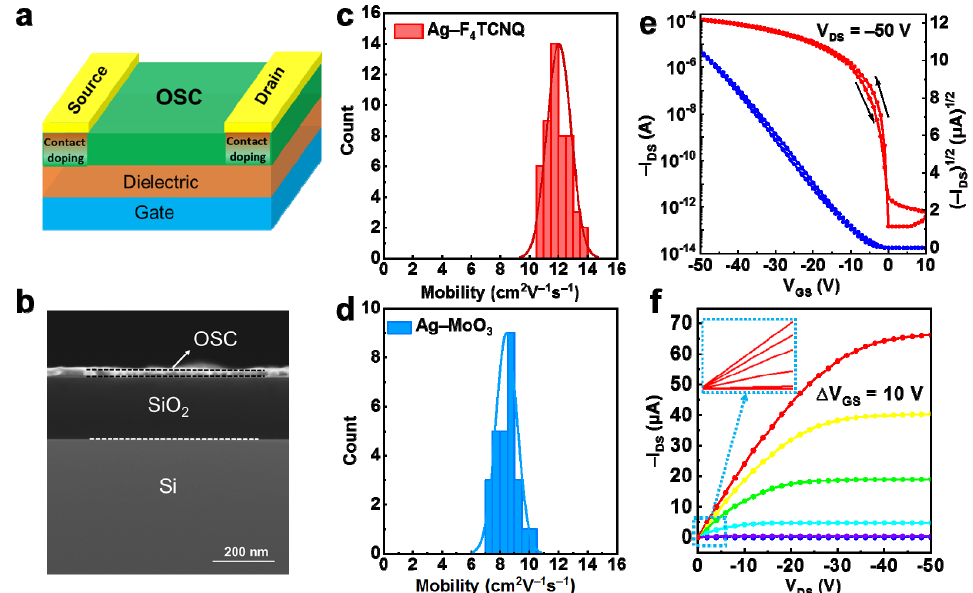
Figure 5. ( a ) Schematic of the devices. ( b ) Cross-sectional scanning electron microscope (SEM) image of the device. ( c ) Histogram of the saturation mobility of OFETs with Ag–F 4 TCNQ electrodes. ( d ) Histogram of the saturation mobility of OFETs with Ag–MoO 3 electrodes. ( e ) Typical transfer curves of the device using Ag–F 4 TCNQ electrodes. ( f ) Typical output curves of the device using Ag–F 4 TCNQ electrodes. Inset shows the enlarged output I - V curves in the low V DS region. The channel length was 100 μ m and the channel width was 100 μ m.